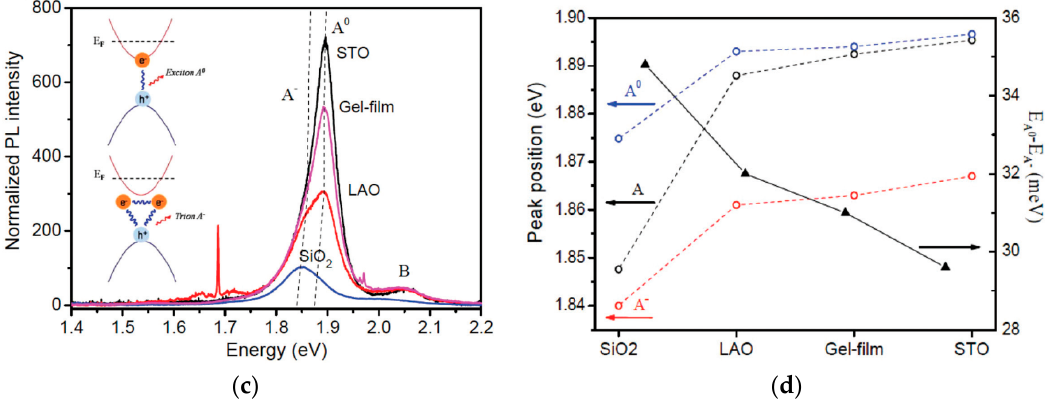
Figure 1. MoS 2 PL properties influenced by dielectric environment and charge doping. ( a ) A typical PL spectrum of single-layer MoS 2 that is fitted with three peaks. The inset schematics demonstrate classical pictures of a trion and an exciton; ( b ) PL peak positions as a function of surrounding solvent dielectric constants (Yuxuan Lin et al. [20]); ( c ) PL spectra of monolayer MoS 2 on SiO 2 , LaAlO 3 , gel-film, and SrTiO 3 substrates; ( d ) Peak positions of PL peak (A), neutral excitons emission (A 0 ), and trion emission (A − ), and energy difference between neutral excitons emission (A 0 ) and trion emission (A − ) (Yuanyuan Li et al. [21]).